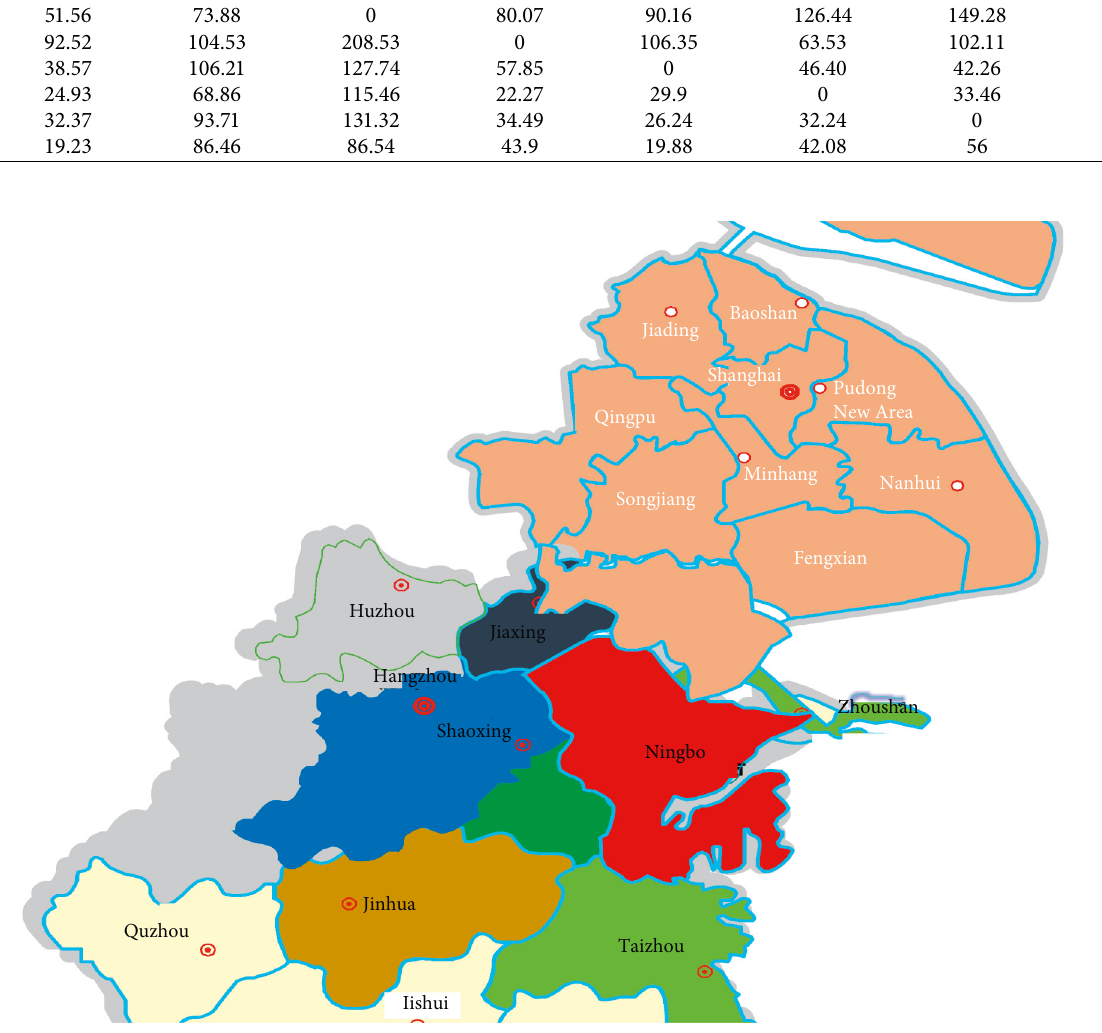
Figure 4: Logistics radiation range of each city.